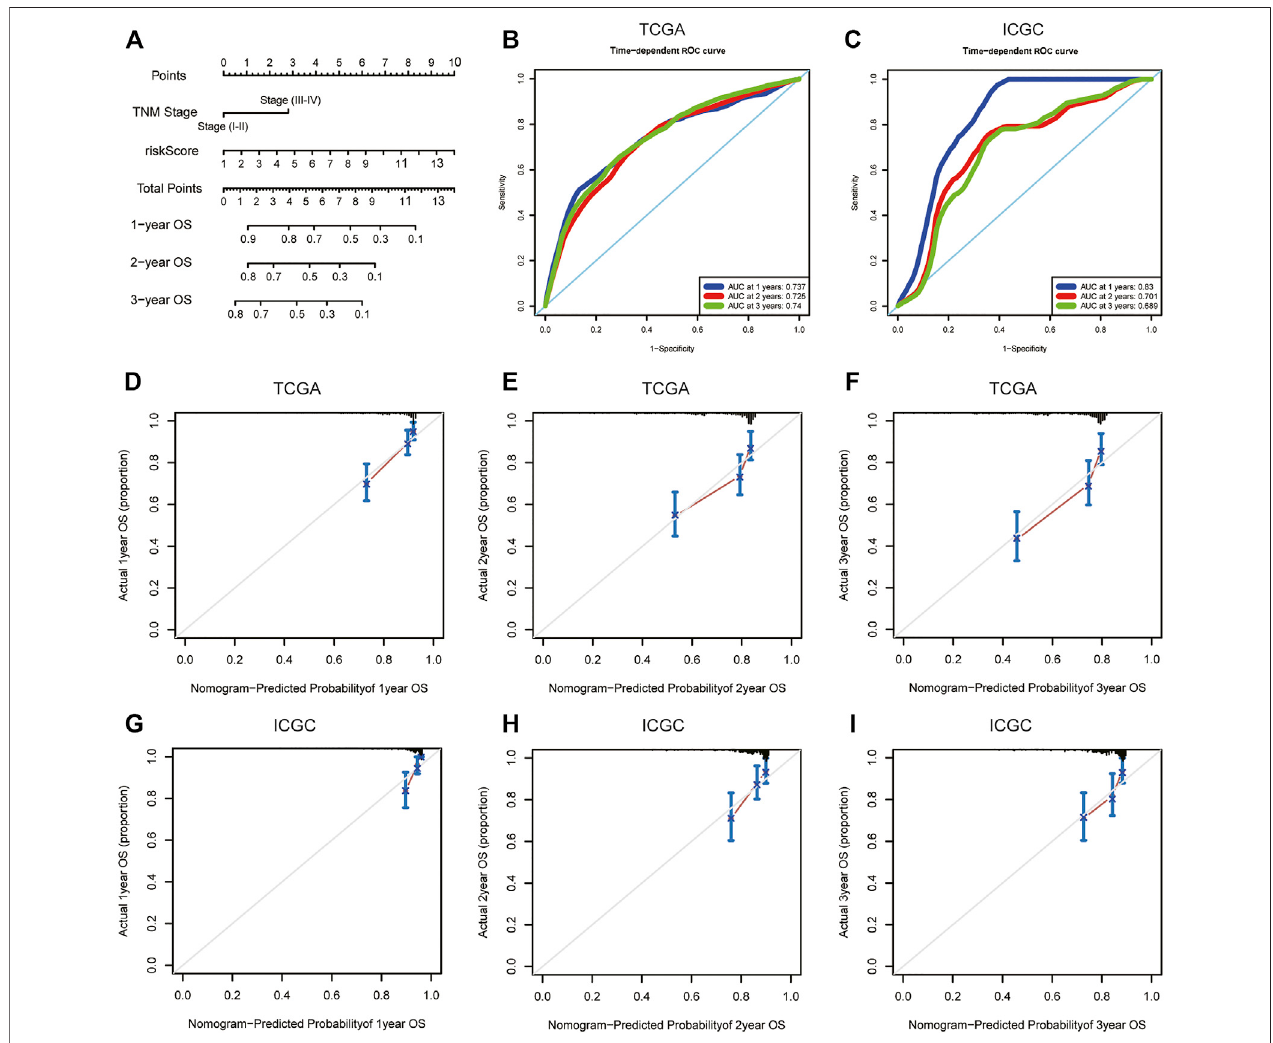
FIGURE7 | OS-related nomogram construction. (A) Theintuitive nomogrammodel isused topredict the1-year, 2-year, and 3-yearOS ratesof HCC patients; (B) The predictive value of the nomogram for the 1-year, 2-year, and 3-year OS rates of HCC patients in TCGA dataset; (C) The predictive value of the nomogram for the 1- year, 2-year, and 3-year OS rates of HCC patients in external ICGC dataset; (D – F) 1-year, 2-year, and 3-year calibration curve of OS-related nomogram in the TCGA dataset; (G – I) 1-year, 2-year, and 3-year calibration curve of OS-related nomogram in the ICGC dataset. OS, overall survival; TCGA, The Cancer Genome Atlas; ICGC, International Cancer Genome